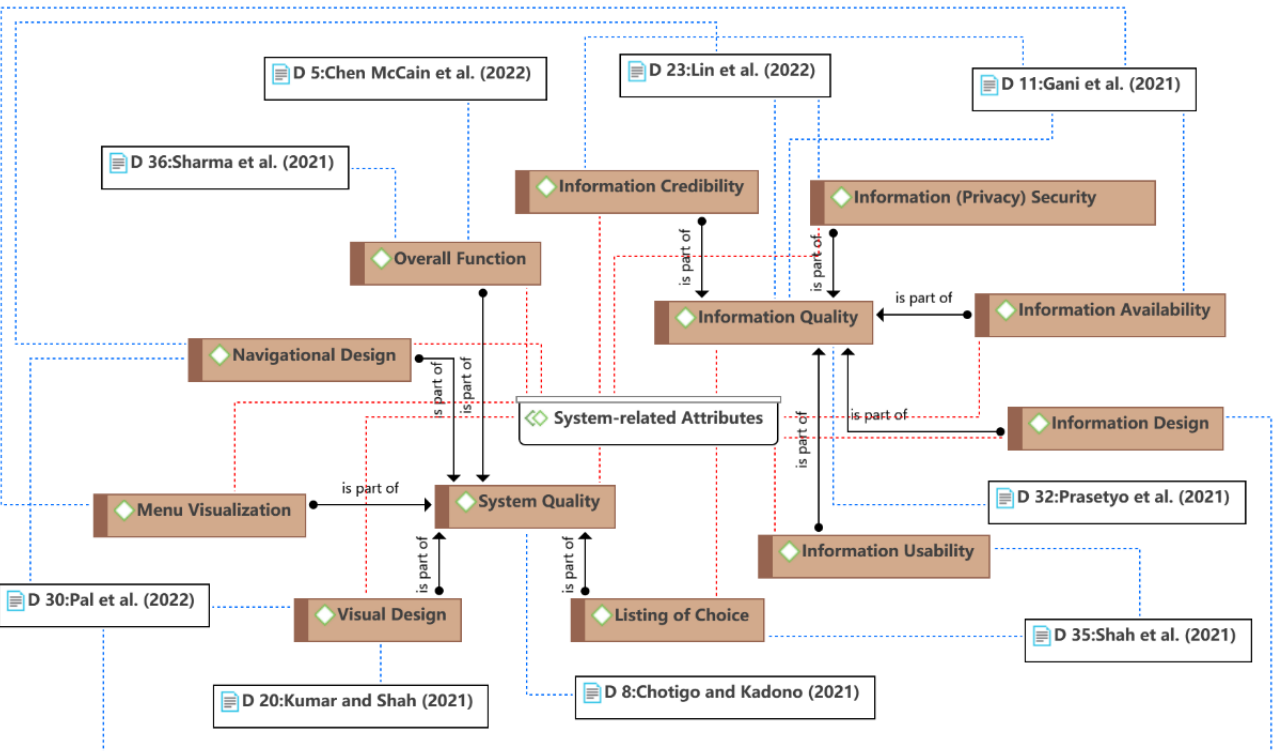
Figure 6. Theme 2: system-related attributes [7,12,27,35,44,46,49 – 51].